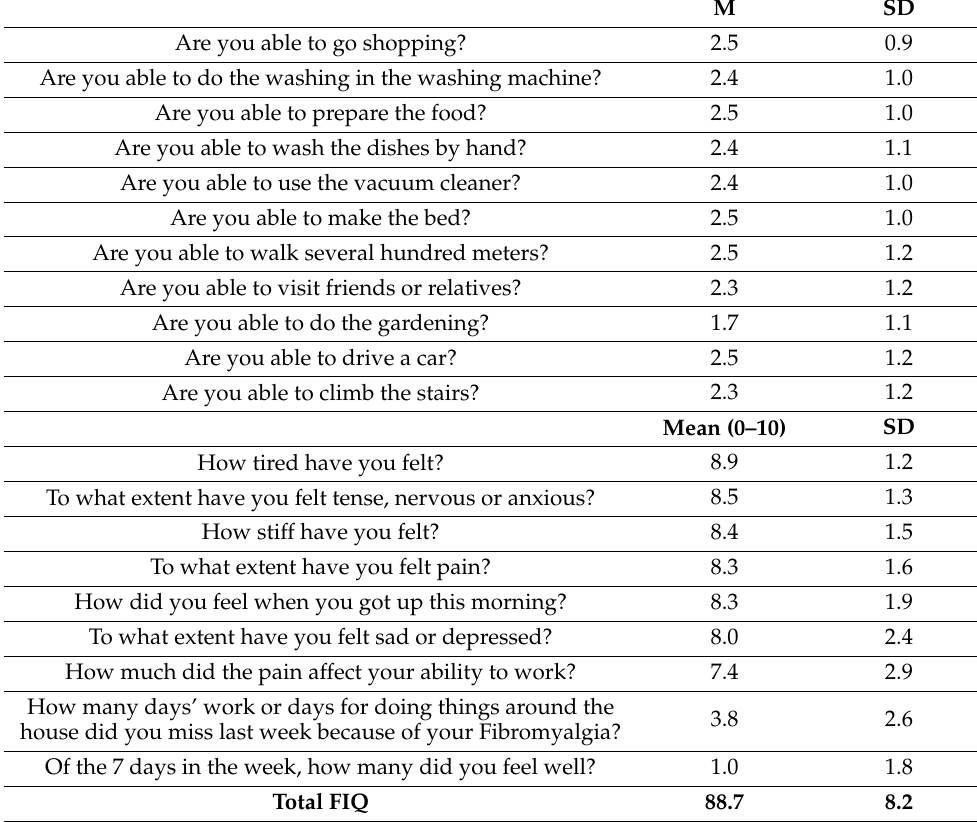
Table 4. FIQ items (daily life activities).